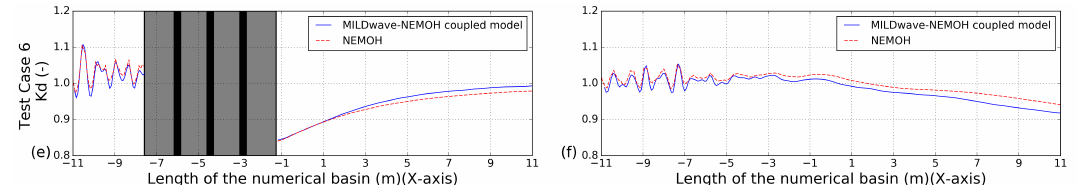
Figure 5. K d results for the MILDwave-NEMOH coupled model and for NEMOH along two longitudinal cross-sections S1 (left) and S2 (right) as indicated in Figure 3 for: ( a , b ) Test Case 2; ( c , d ) Test Case 4, and ( e , f ) Test Case 6. The coupling region is masked out in gray colour and includes the WECs’ cross-sections, which are indicated by black vertical areas.